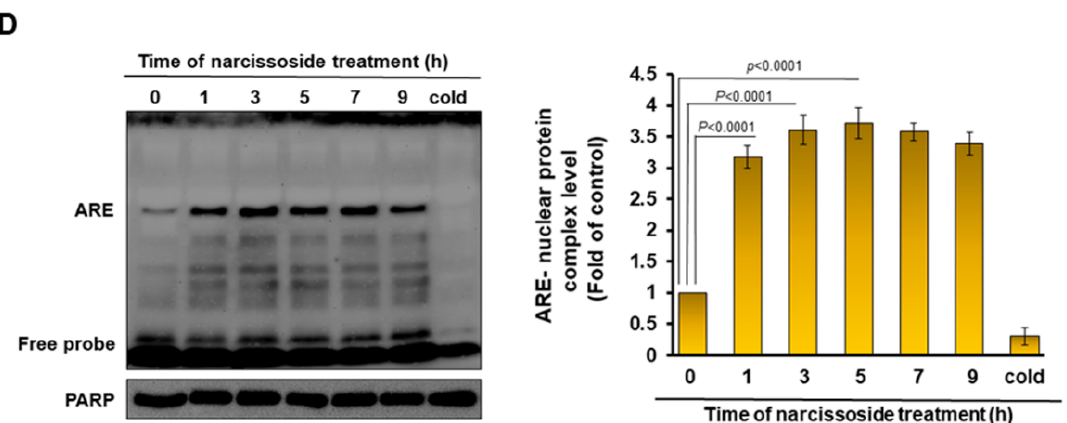
Figure 6. Treatment with narcissoside (NCS) raises the amount of nuclear factor erythroid 2–related factor 2 (Nrf2) in the nucleus of SH-SY5Y cells to enhance the transcriptional activity initiated by binding of the antioxidant response element (ARE). ( A ) Cells were incubated with 1- μ M NCS for 0, 1, 3, 5, 7, and 9h. Nuclear Nrf1 and Nrf2 was determined by Western blotting. PARP was used as the internal loading control. (B-C) Cells were transfected with the ARE reporter plasmid for 24 h and then treated with 1 μ M NCS for 0, 1, 3, 5, 7, or 9 h ( B ) or treated 0, 0.1, 0.25, 0.5, or 1 μ M NCS for 5 h ( C ). Luciferase activities were determined by Luciferase assay kit. ( D ) Electromobility gel shift assay (EMSA) was used to quantify the ARE binding activity of nuclear extracts (Nrf2) from ( A ). Unlabeled double-stranded ARE oligonucleotide (200 ng, cold competitors) was used to confirm the specific binding.